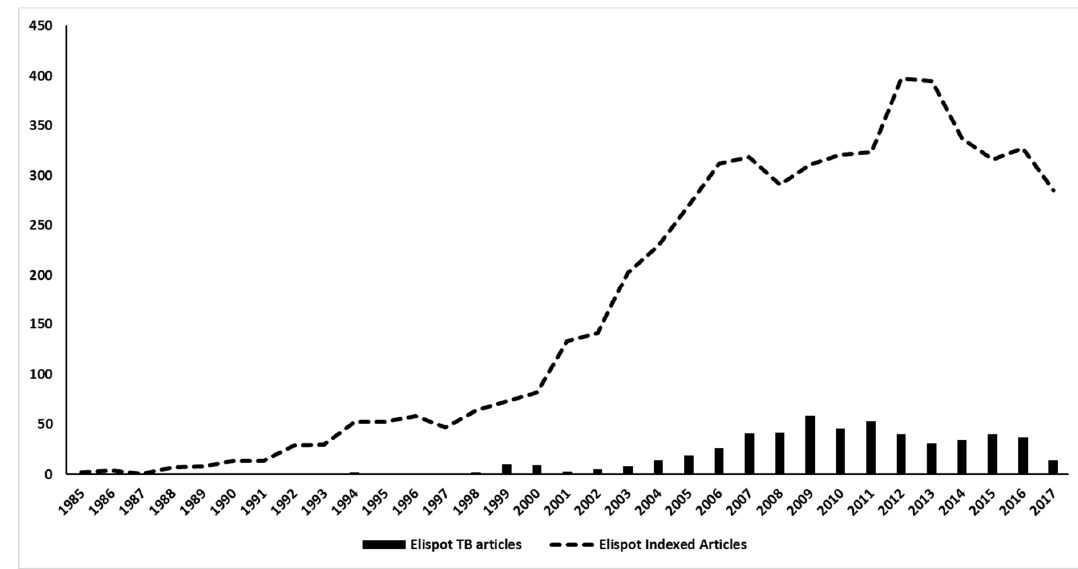
Figure 5. Number of PubMed indexed articles using Elispot technique in the Tuberculosis field since the first description in 1990.